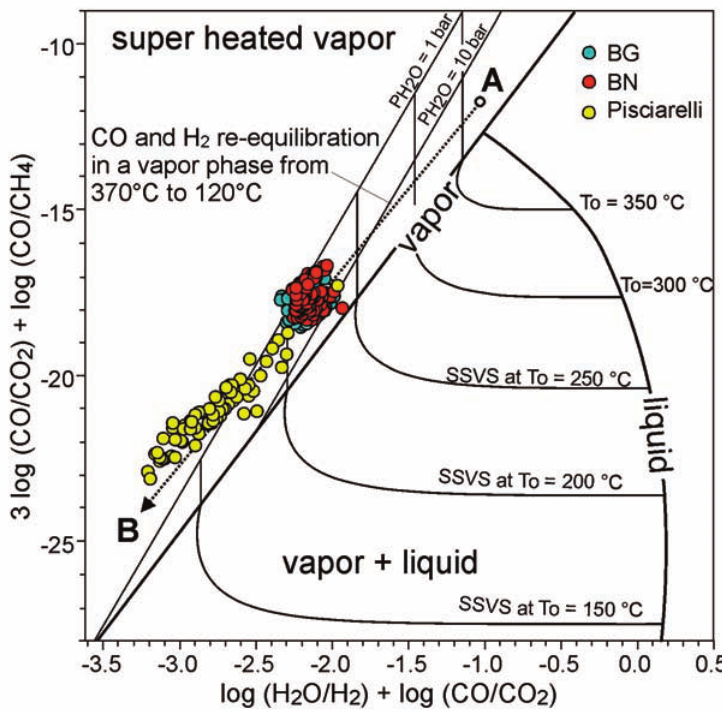
Figure 3. Theoretical values of log(X /X ) + log(X /X ) versus 3log(X /X ) + log(X /X ) for a single saturated vapor phase and a single saturated H2O H2 CO CO2 CO CO2 CO CH4 liquid phase, shown as the vapor line and the liquid line, respectively. The equilibrium gas contents in a single saturated liquid phase were computed using the vapor–liquid distribution coefficient, Bi, defined as Bi = (X /X ) /(X /X ) . The composition of the vapors separated in a single step at varying i i H2O vap H2O liq temperatures (T ) (single-step vapor separation lines, or SSVS lines) and the compositions of superheated vapors equilibrated at different T–P 0 lines) are also shown. The equilibrium conditions for the high-temperature fumaroles of the Solfatara crater (BG and BN) can be inferred for a superheated vapor phase at temperatures between 200 ˚C and 240 ˚C, and between 200 ˚C and about 150 ˚C for the Pisciarelli fumarole. The possible occurrence of and CO re-equilibration upon cooling of the gas phase (see text) has also been investigated through drawing of the single gas-phase theoretical re- H 2 equilibration line from 370 ˚C (point A) to 120 ˚C (point B) under the redox conditions controlled by the buffer of D'Amore and Panichi [1980] (see the text for further details). The Solfatara compositions plot along the re-equilibration pathway, which supports the occurrence of such